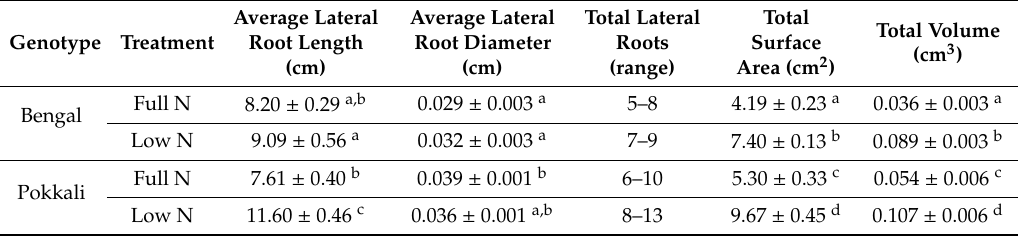
Figure 3. Root architectures of Pokkali and Bengal seedlings under low and full nitrogen treatment.